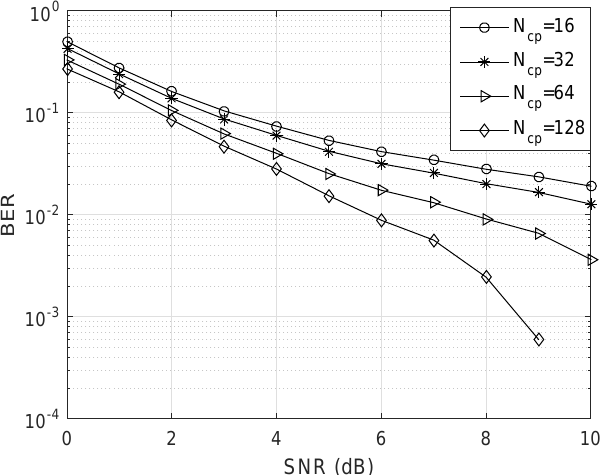
Figure 5. BER versus SNR with N cp . As we predicted, the BER increases as N cp decreases. Since N is defined to be proportional to N cp , while N cp should be greater than the channel delay spread L to eliminating the interference, there exists tradeoffs between the CP length and the subcarrier spacing as well as the CP length and the tag